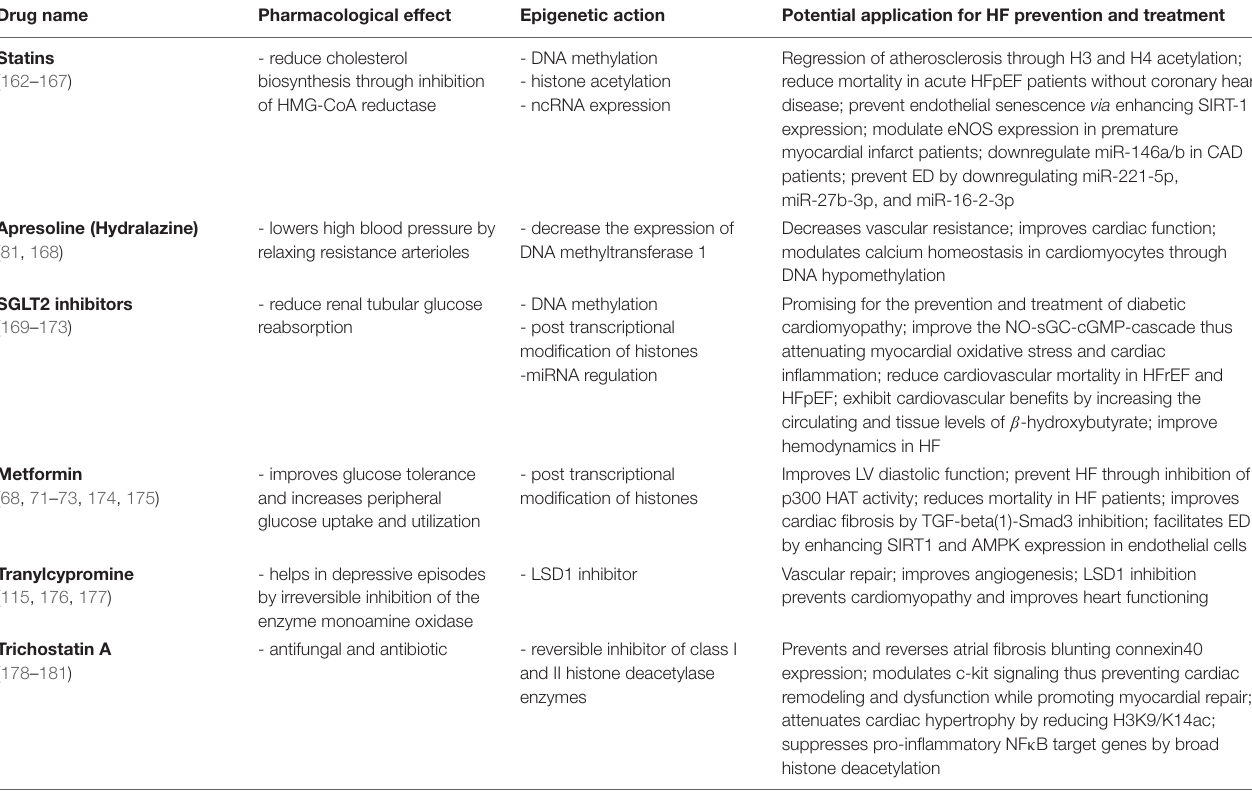
TABLE 1 | Widely used drugs with known epigenetic effects and potential use in HF.